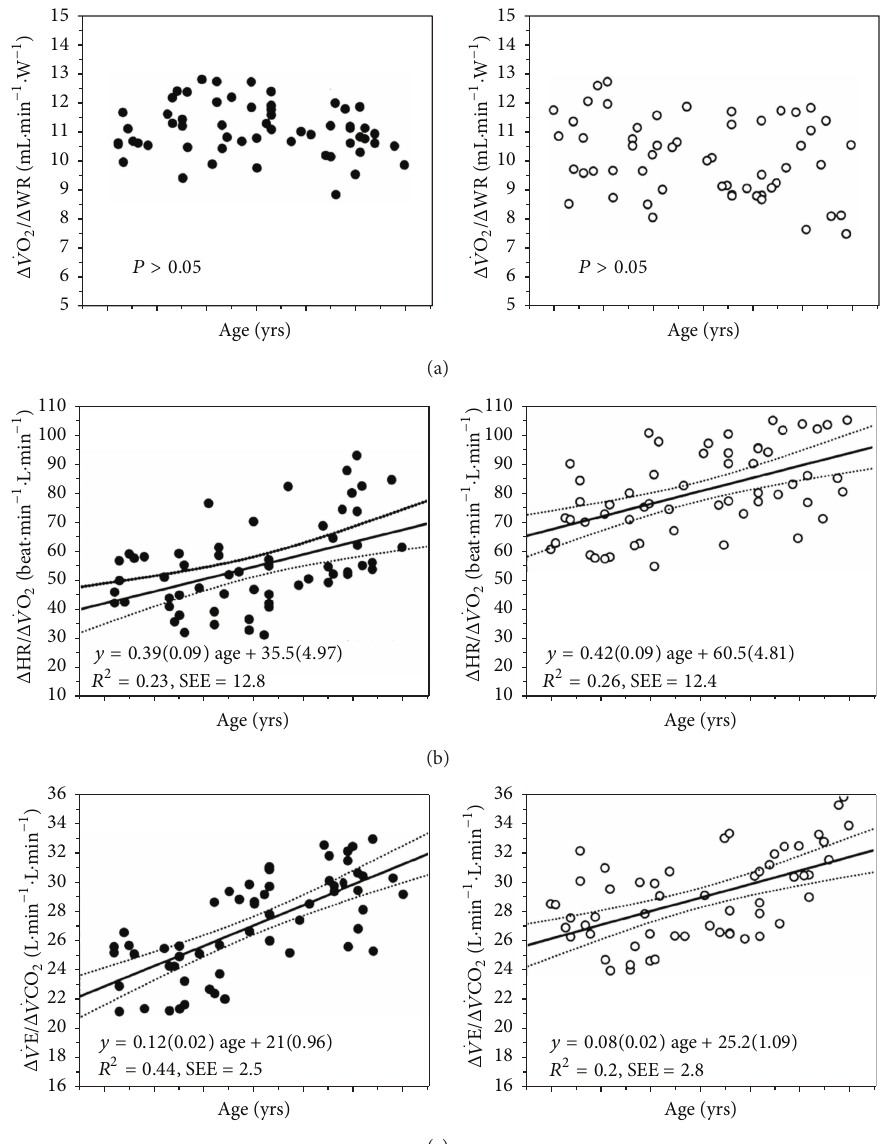
Figure 3: The submaximal relationships depicted in Figure 2 as a function of age in males (left panels) and females (right panels). Regression linesareshownwiththeirrespective95%confidenceintervalsforthoserelationshipsinwhichthevariableswereinfluencedbyage.Regression coefficients and intercepts of the linear prediction equations are depicted with their respective standard error of the estimate (SEE). (Modified with permission from